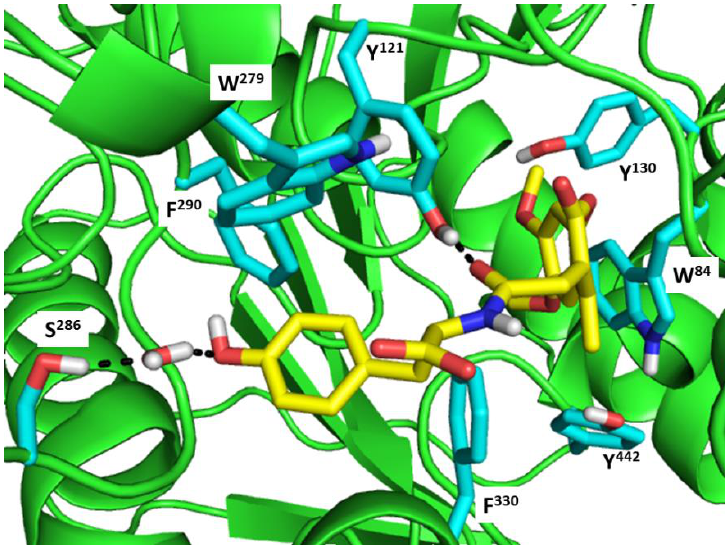
Figure 1. Compound ZINC000002159521 in the AChE binding pocket at its lowest total energy from the short MD simulations. The main chain of AChE is presented as a cartoon in green. The carbon atoms of the binding residues and ZINC000002159521 are presented as sticks in cyan and yellow, respectively. The oxygen and hydrogen atoms are presented as sticks in red and white, respectively. The hydrogen bonds are presented as black dashed